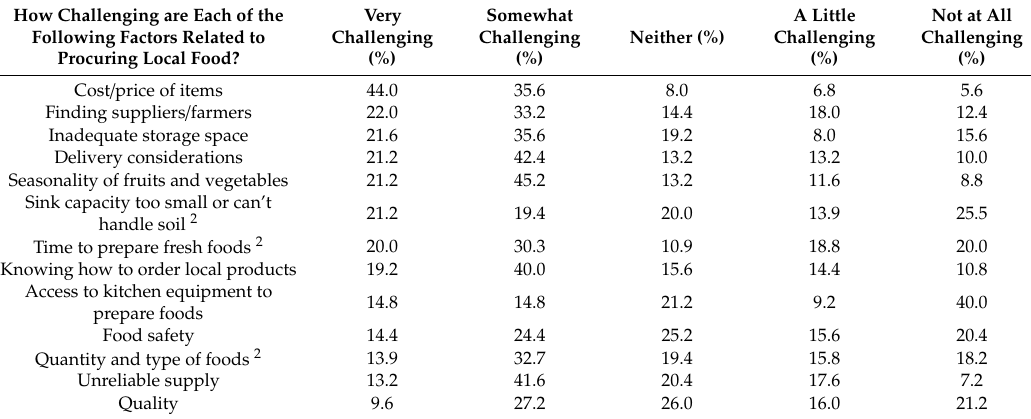
Table 2. Perceived challenges of local food procurement among licensed Colorado Early Care and Education providers 1